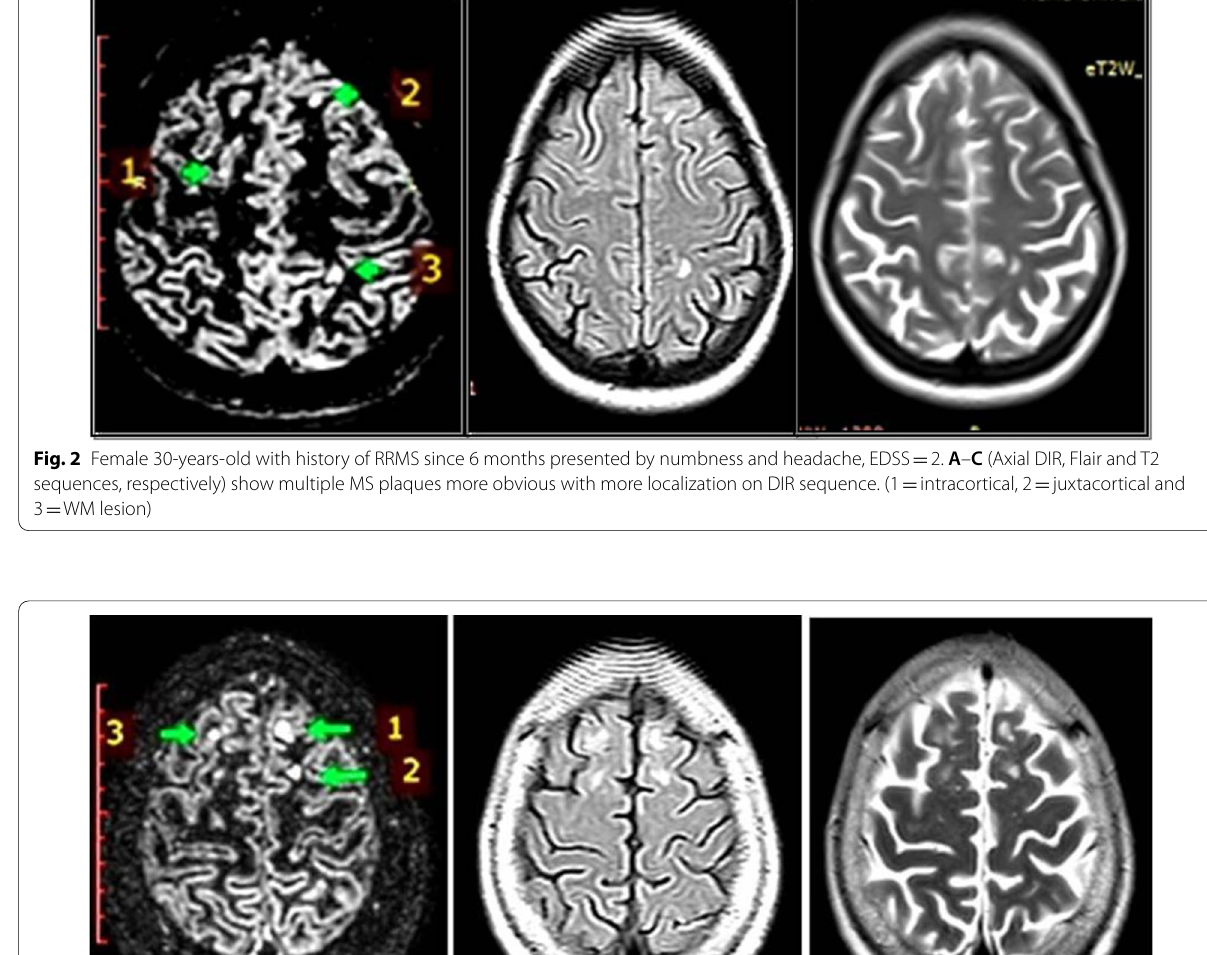
Fig. 3 Female patient 30-years-old with history of RRMS since 4 years presented by weakness, headache and visual disorder, EDSS (Axial DIR, Flair and T2 sequences, respectively) show MS plaques noted at different anatomical locations more obvious on DIR sequence. (1 leukocortical lesion, 2 WM lesion and 3 intra-cortical = = =